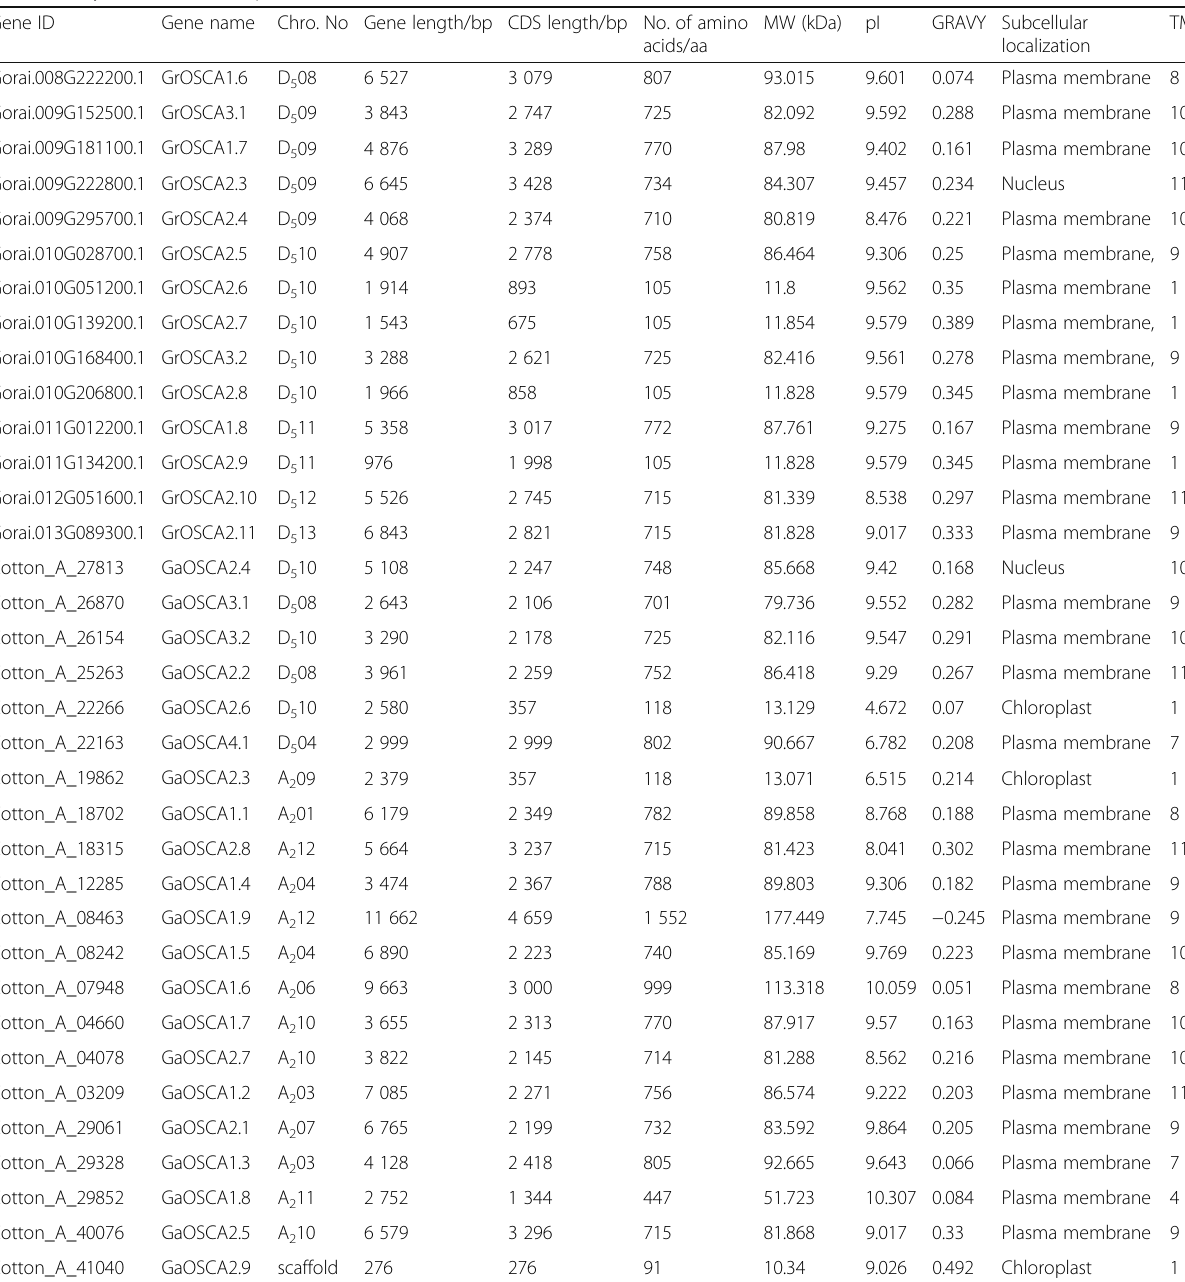
Table 2 Physicochemical Properties of OSCA Gene (Continued) Gene